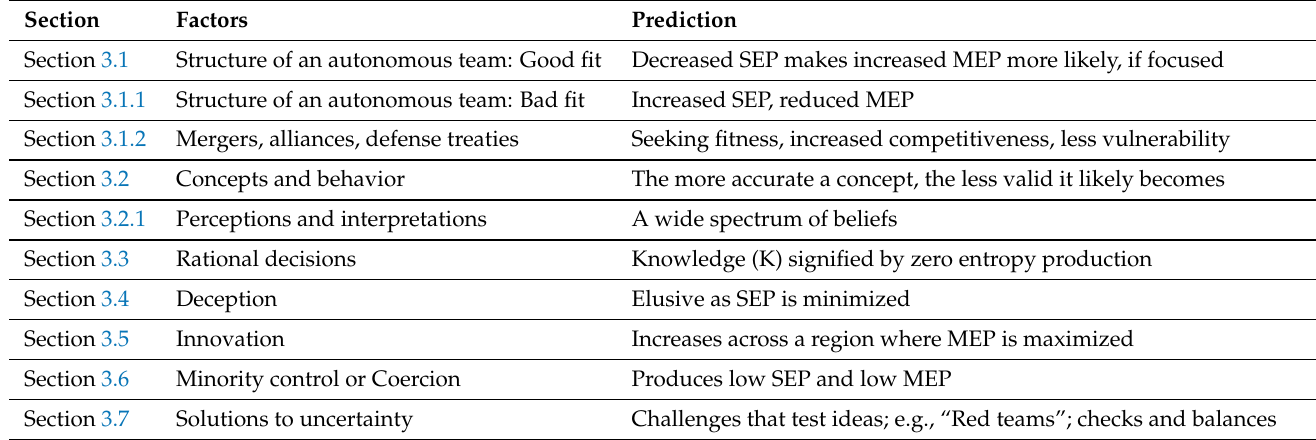
Table 2. Predictions and